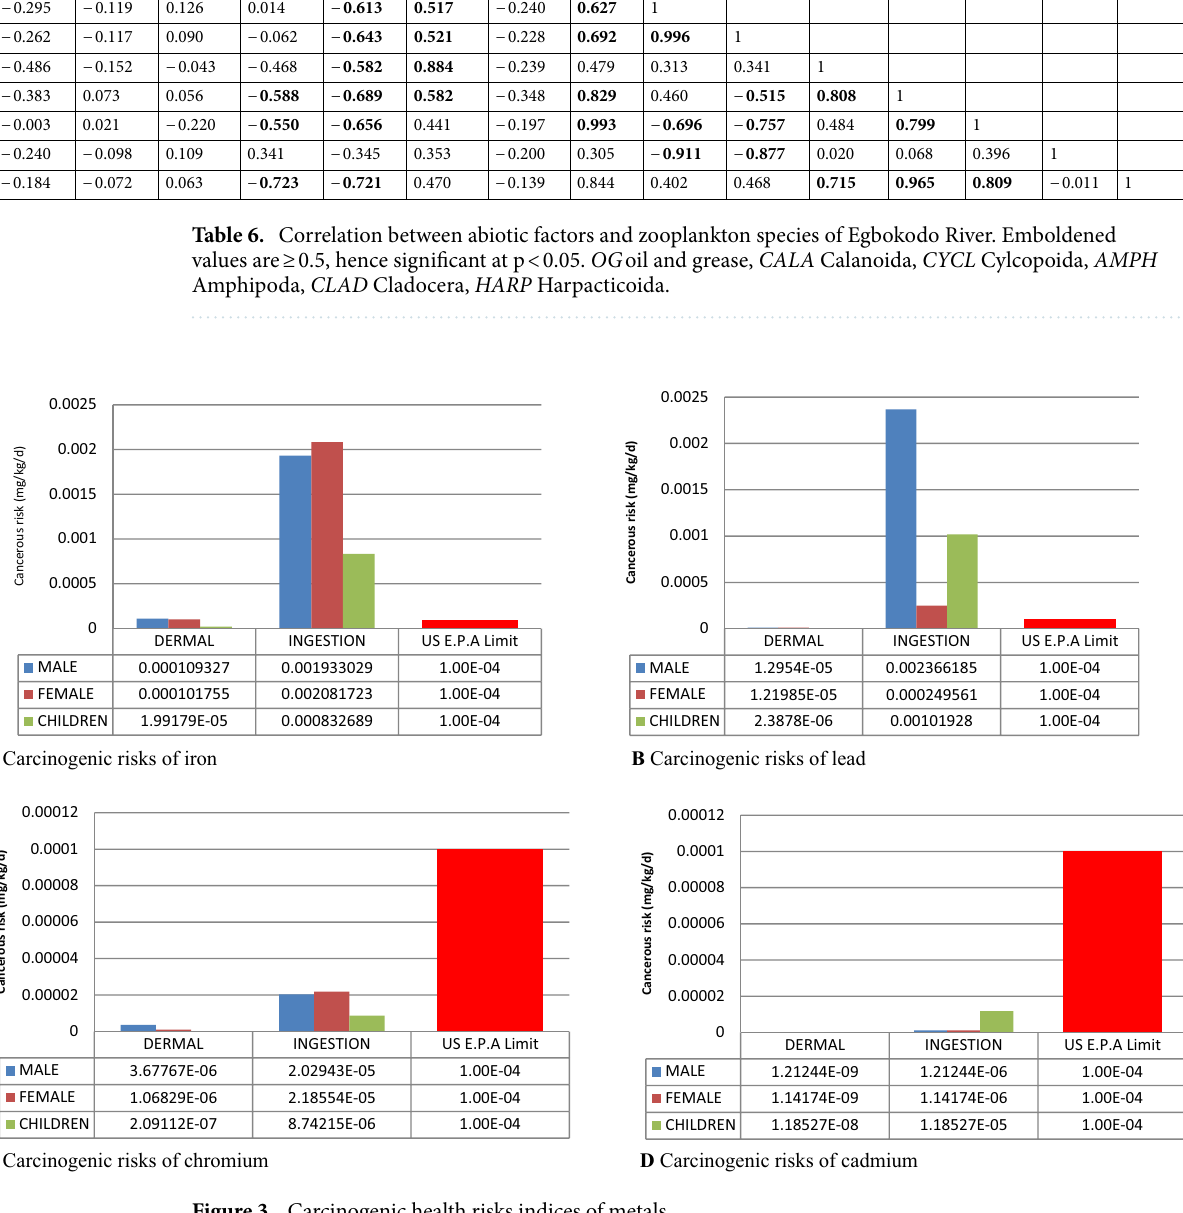
Figure 3. Carcinogenic health risks indices of